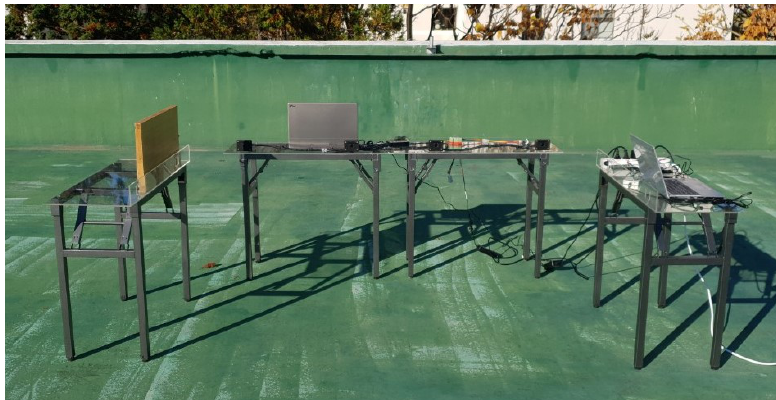
Figure 11. Measurement of the obstacle 2 m way from the transducer.